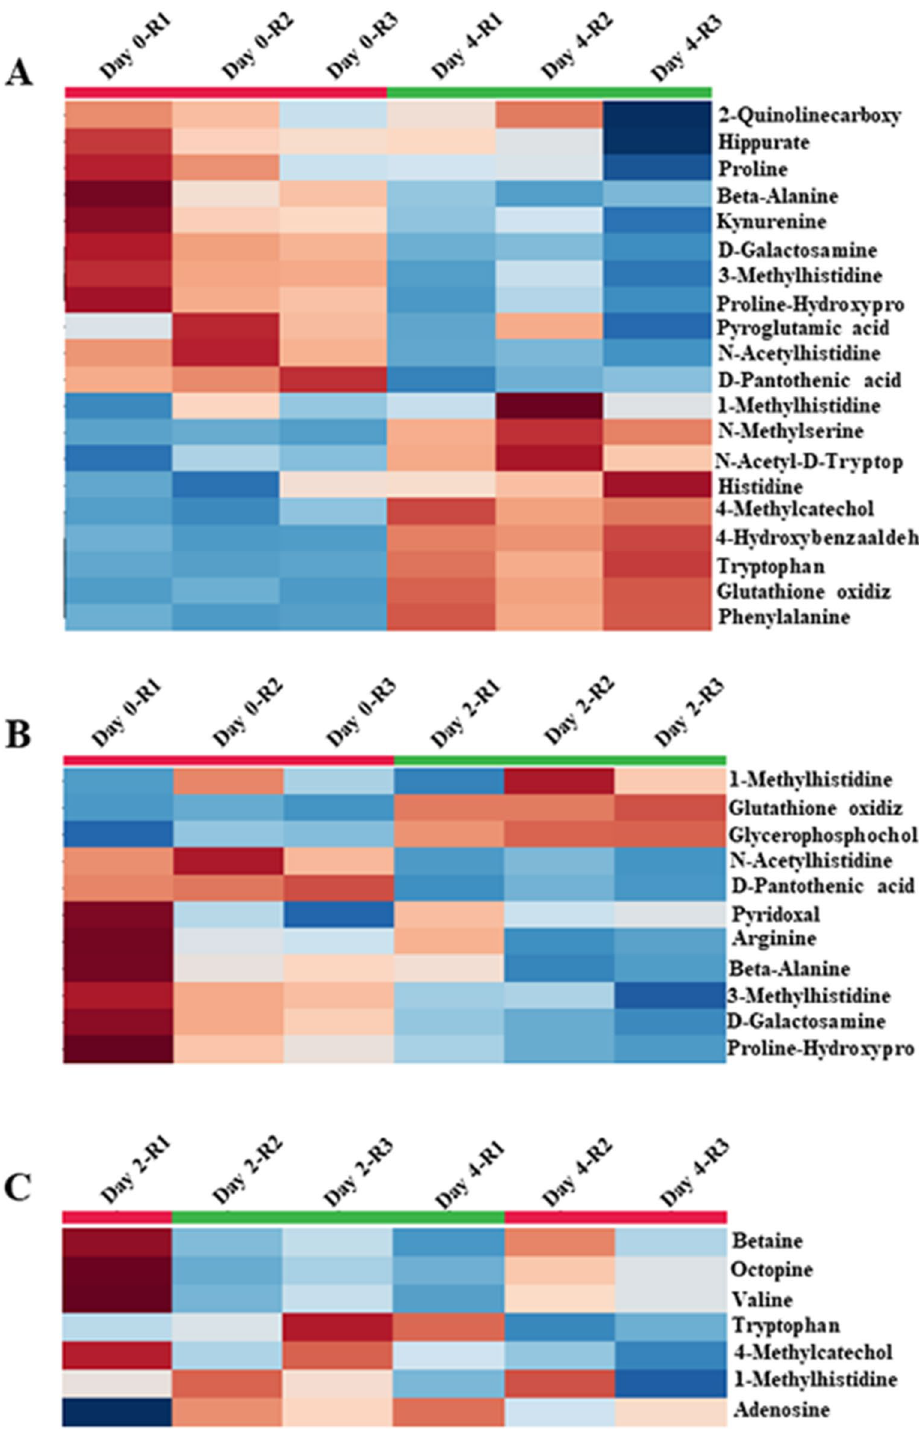
Figure 2. Heat map displaying metabolites that were significantly altered over the progression of myogenic culture. ( A ) 20 metabolites that were differentially altered from proliferating myogenic culture (Day 0) to late differentiating culture (Day 4). ( B ) 11 metabolites that were differentially altered from proliferating (Day 0) to early differentiating myogenic culture (Day 2). ( C ) 7 metabolites that were differentially altered from early (Day 2) to late differentiating culture (Day